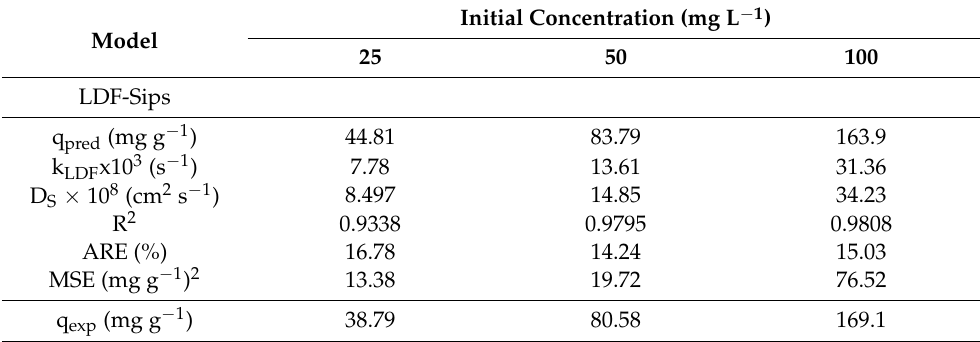
Table 3. The kinetic parameters were estimated for the adsorption of 2,4-D in the AC.